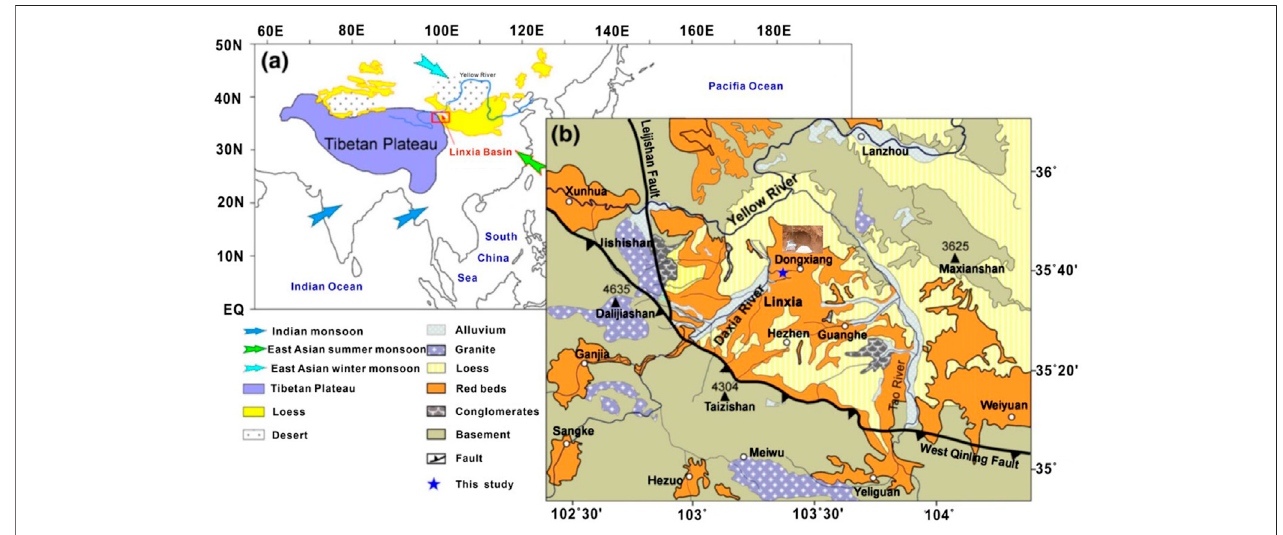
FIGURE 1 | Location of the Linxia Basin (A) and the geological map of the Linxia Basin and adjacent regions in this study area (modi fi ed from Yang et al., 2016).